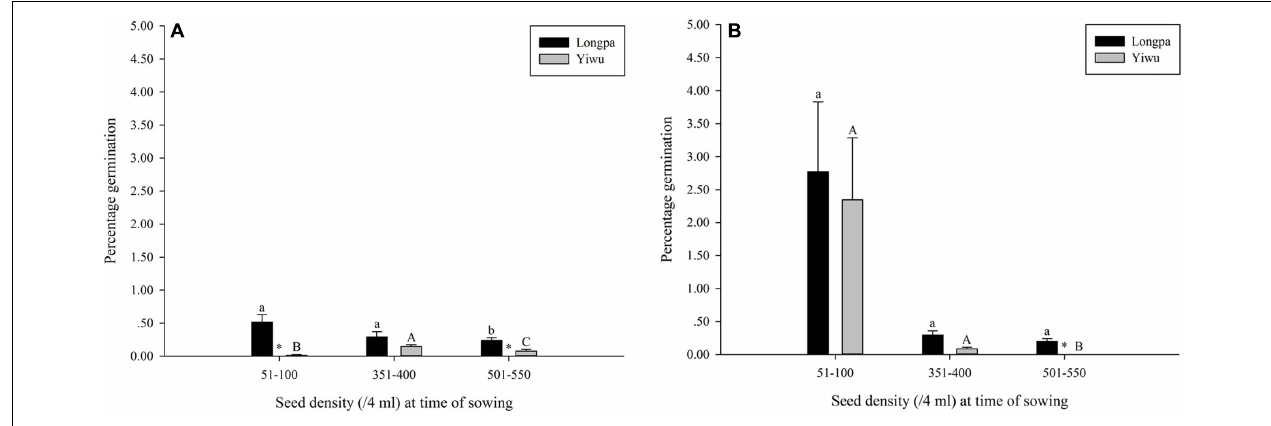
FIGURE 2 | The effect of seed density at time of sowing for (A) Plastic Wrap and (B) Plastic Wrap + packet treatments on in situ symbiotic seed germination for D. devonianum at Longpa and Yiwu, Yunnan, China. Significant differences among seed densities are indicated by letters. Astericies show significant differences among sites. TABLE 2 | The effect of two seed sowing densities on seed germination in D. devonianum for two treatments (Plastic Wrap and Plastic Wrap + packet) at the Longpa and Yiwu study sites, Yunnan, China.